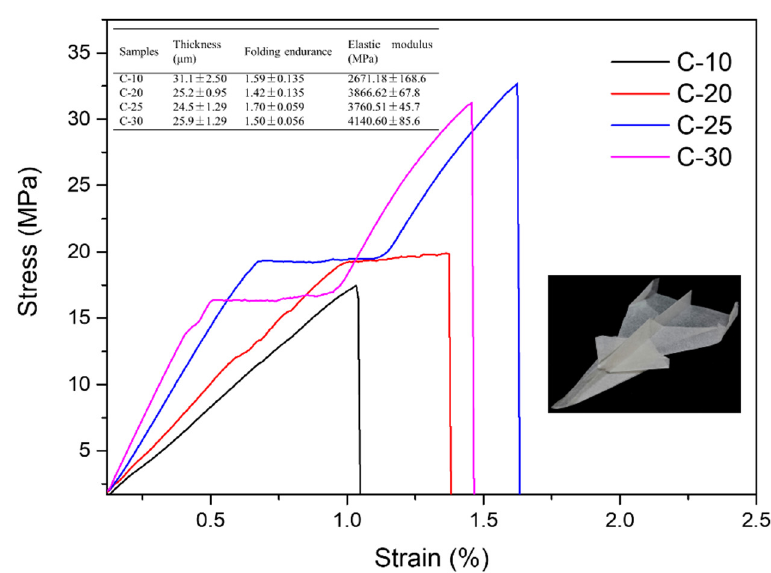
Figure 8. Stress–strain curves of the nano/microfibrils-based films.